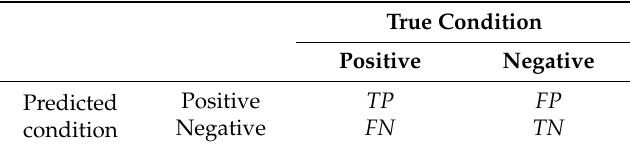
Table 1. Confusion